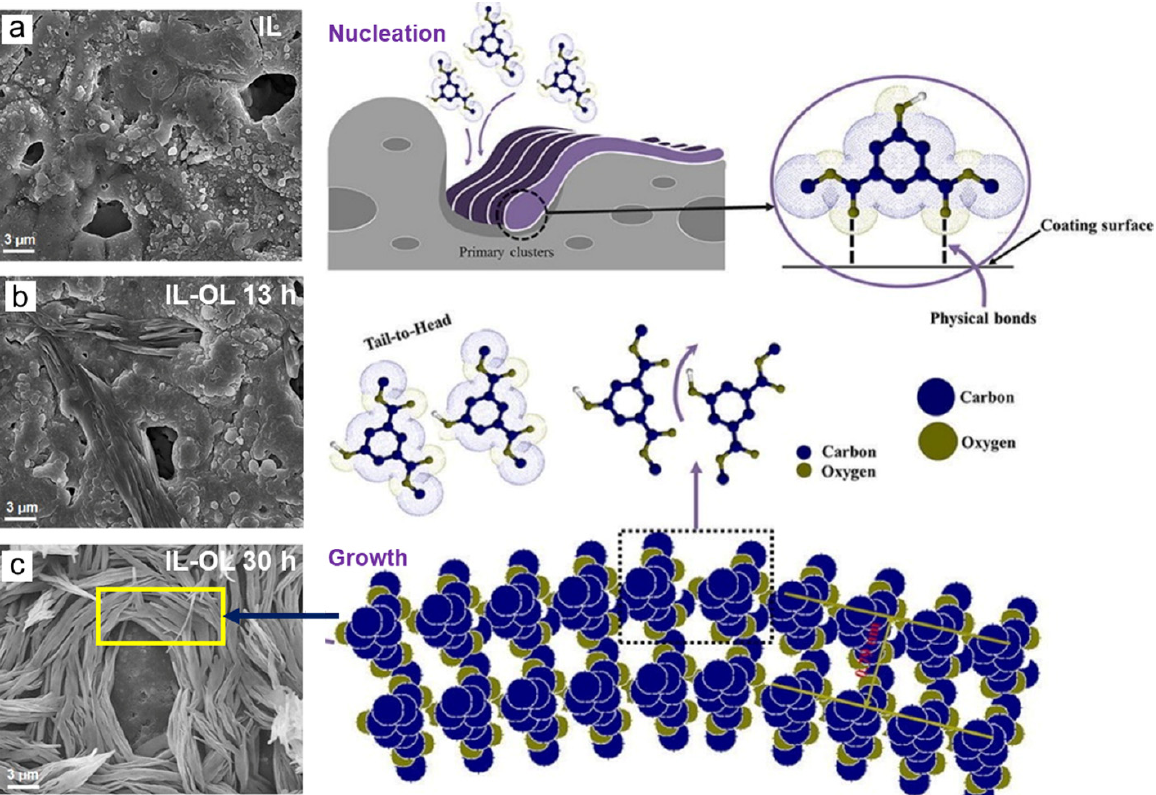
Figure 2. Surface morphologies of IL after PE ( a ) and IL-OL with 3D basket-weave structure after dip chemical coating in DMIP solution at room temperature for 13 h ( b ) and 30 h ( c ), respectively accompanied with the illustration of nucleation and growth of the organic cluster. Redrawn with permission from [10]. Copyright © 2019 Elsevier.